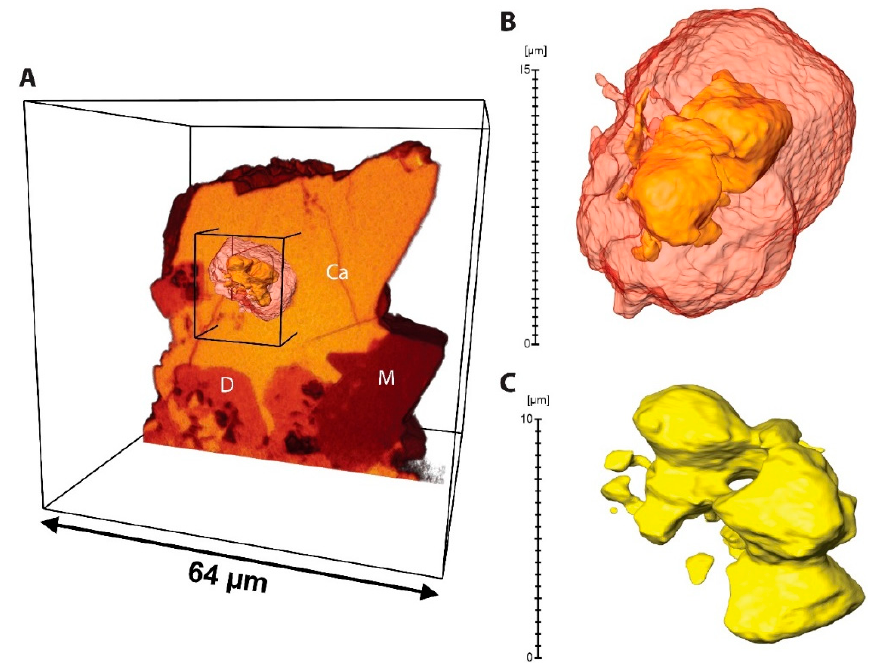
Figure 16. 3D renderings of the nanotomographic reconstruction of a fragment from the same sample as Figure 15. ( A ) Dolomite microspheres (D) and detrital mica (M) are encased in calcite microspar cement (Ca); ( B ) 3D rendering of a single microsphere. The red envelope is made of dolomite. The yellow volume is the internal porosity of the microsphere. ( C ) Isolation of the internal porosity of the microsphere visualized in (B).